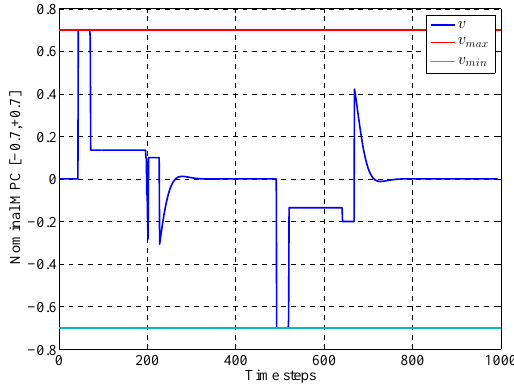
Figure 12: Nominal MPC component of the proposed control